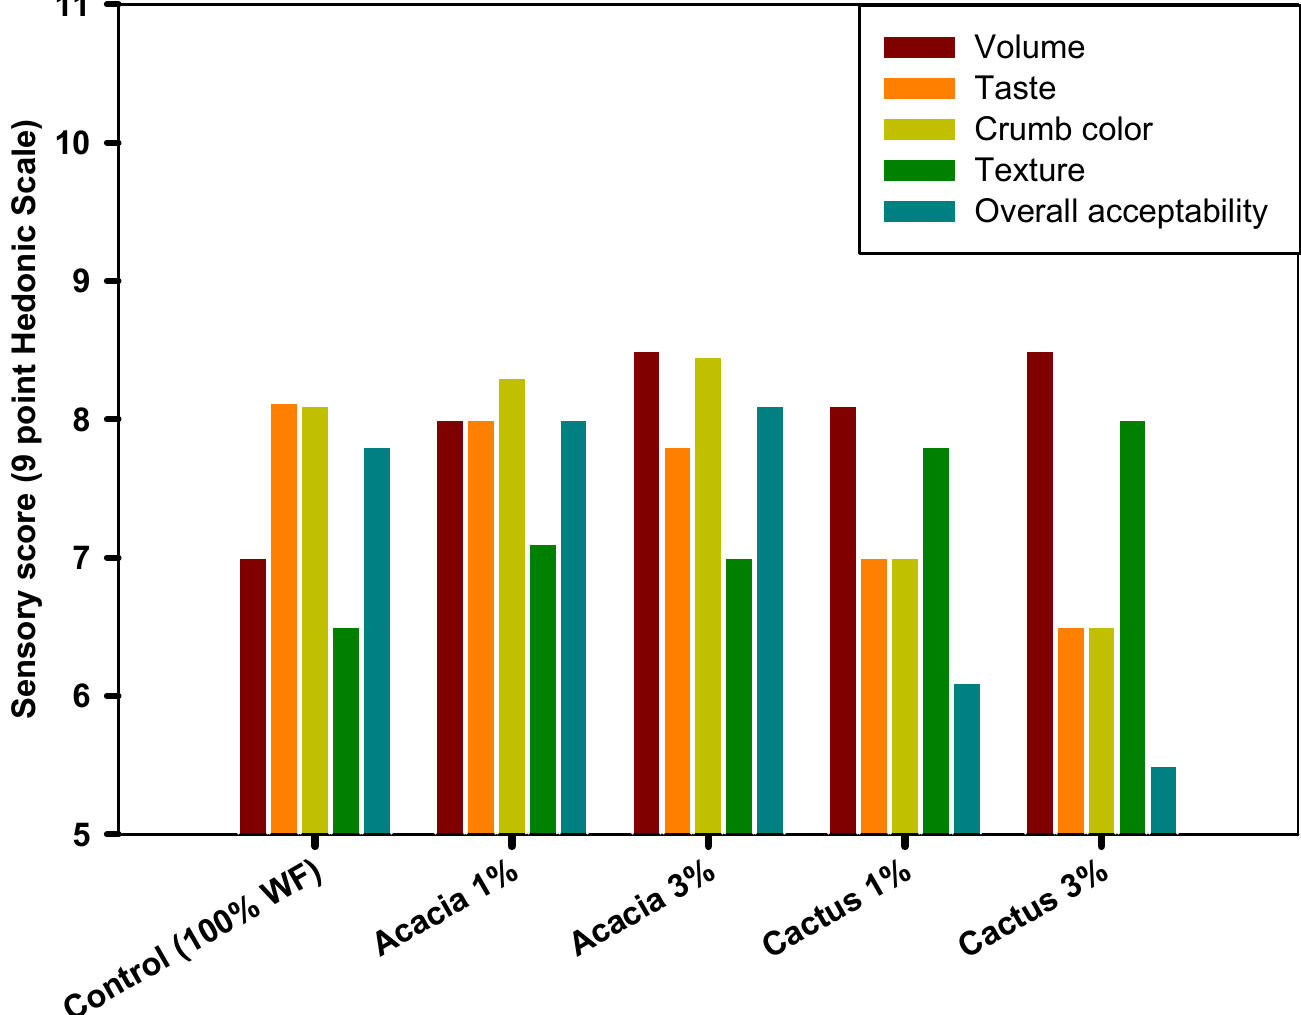
Figure 4. Sensory score of bread containing acacia and cactus gums.